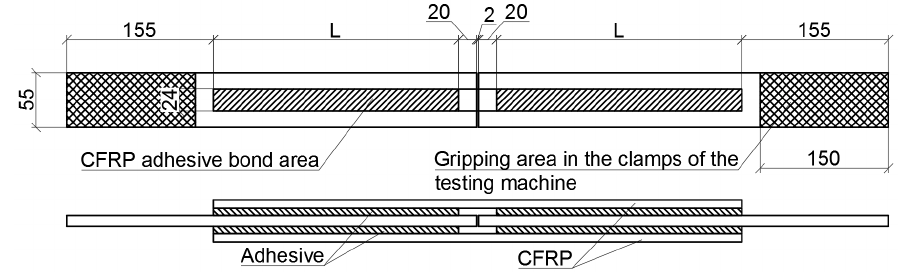
Figure 2. Adhesive bond